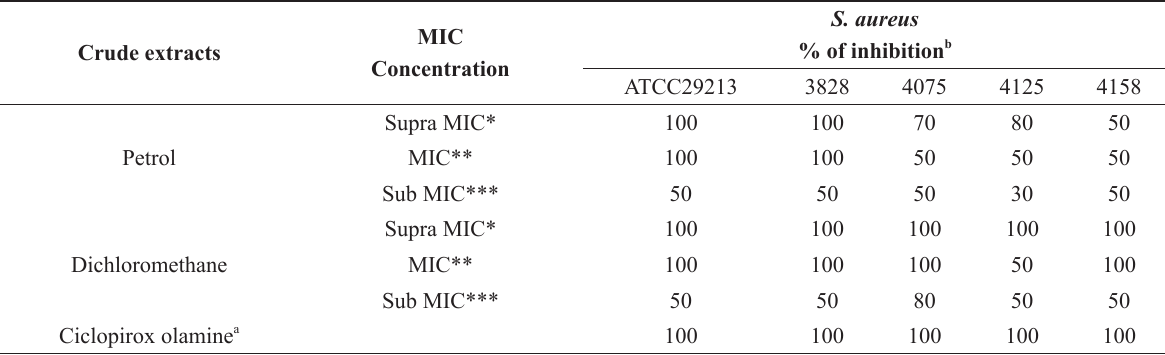
BIC values obtained from the actives extracts of Plectrantus ornatus on Staphylococcus aureus strains. Crude